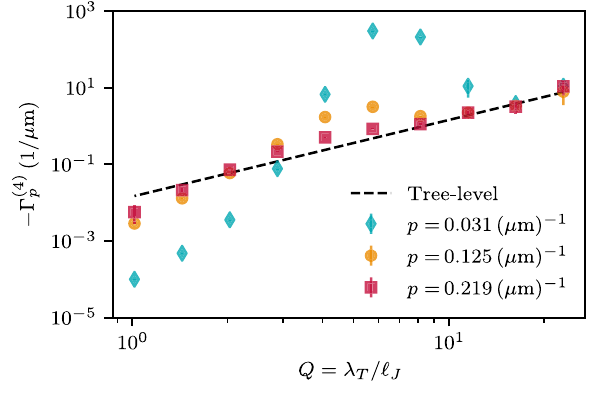
FIG. 6. The 1PI four-vertex as a function of Q for three different momenta p ¼ 0 . 031 (blue diamonds), 0.125 (orange circles), and 0 . 219 μ m − 1 (red squares). At large momenta, the vertex ap- proaches the tree-level prediction (black dashed line). At low momenta, loop corrections lead to a suppression or an enhance- ment depending on the values of Q and p (cf. Fig. 5). Numerical results are calculated for L ¼ 100 μ m and a sample size of 10 8 .